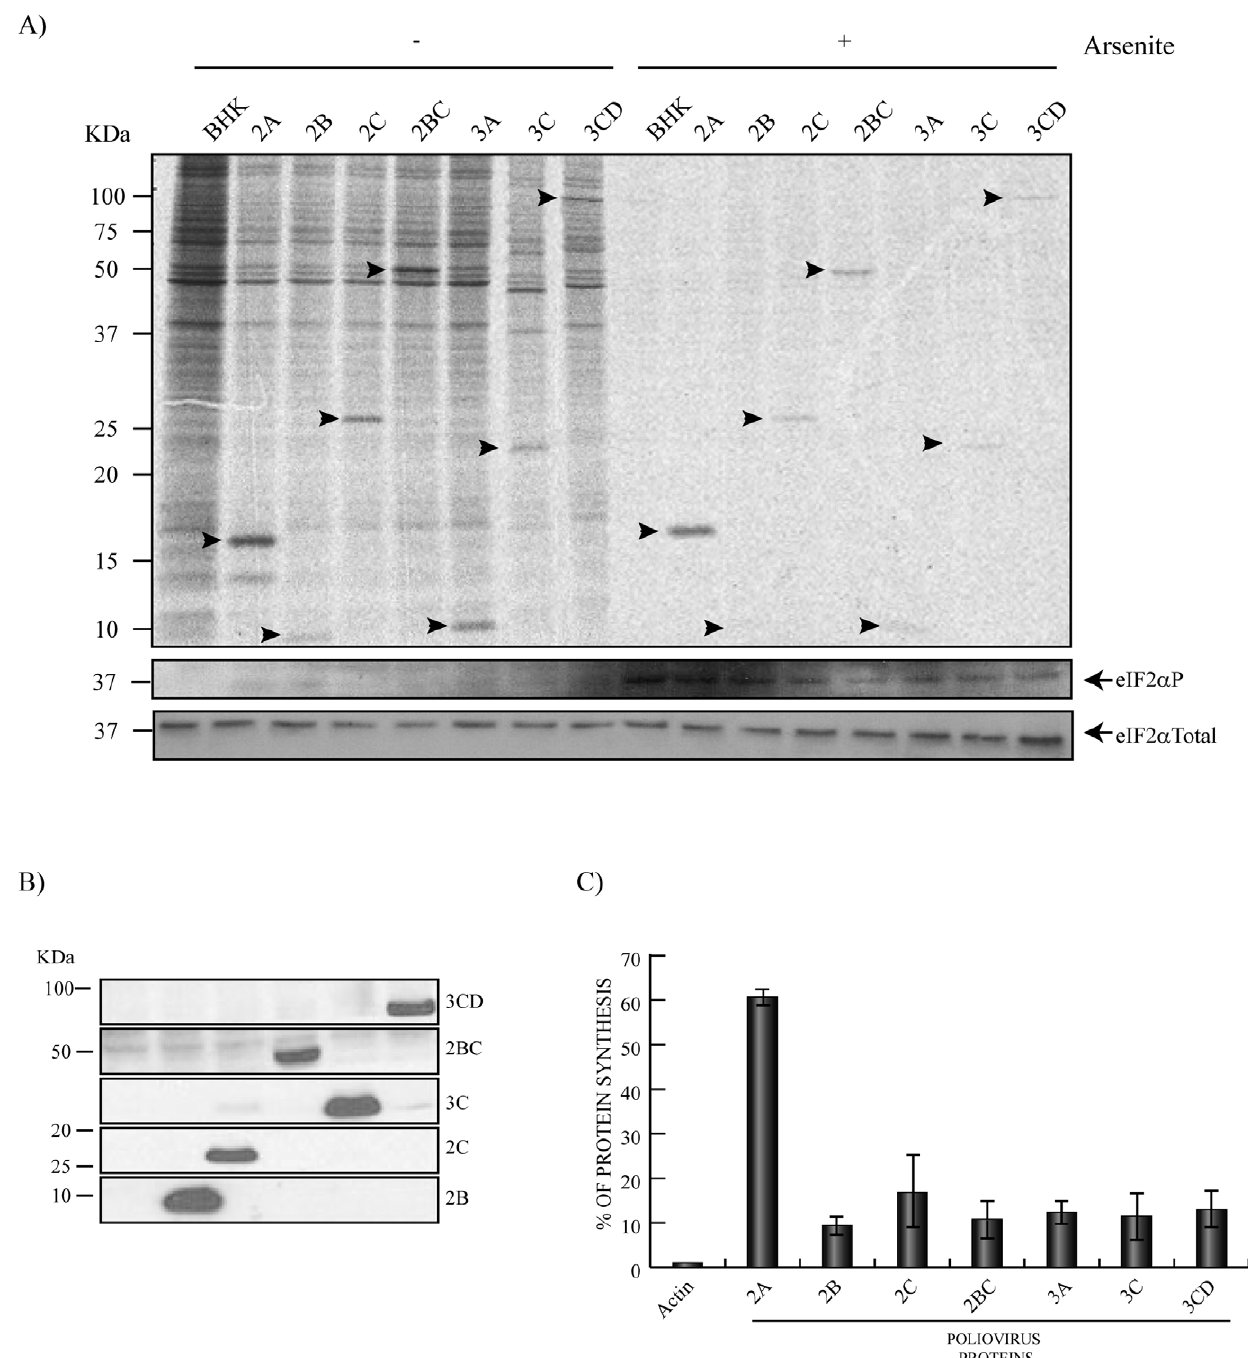
Figure 2. Individual expression of PV non structural proteins. Action of eIF2 phosphorylation. BHKT7 cells were transfected with pTM1 plasmids encoding different PV non-structural proteins and were( + ) or were not( 2 ) treated with Ars. A) After 2 hpt cells were pre-treated with 200 m M Ars for 15 minutes and then labelled with [ 35 S]Met/Cys for 45 minutes in presence of the inhibitor. Then, samples were processed by SDS- PAGE (17.5%), fluorography and autoradiography. Western blot of total eIF2 a and phosphorylated eIF2 a using the same samples is shown at the bottom of this panel. B) PV non-structural proteins were detected by western-blot. C) The percentage of actin (*) and each PV protein synthesis was estimated by densitometric scanning of the corresponding band (arrows) from three independent experiments. Error bars indicate